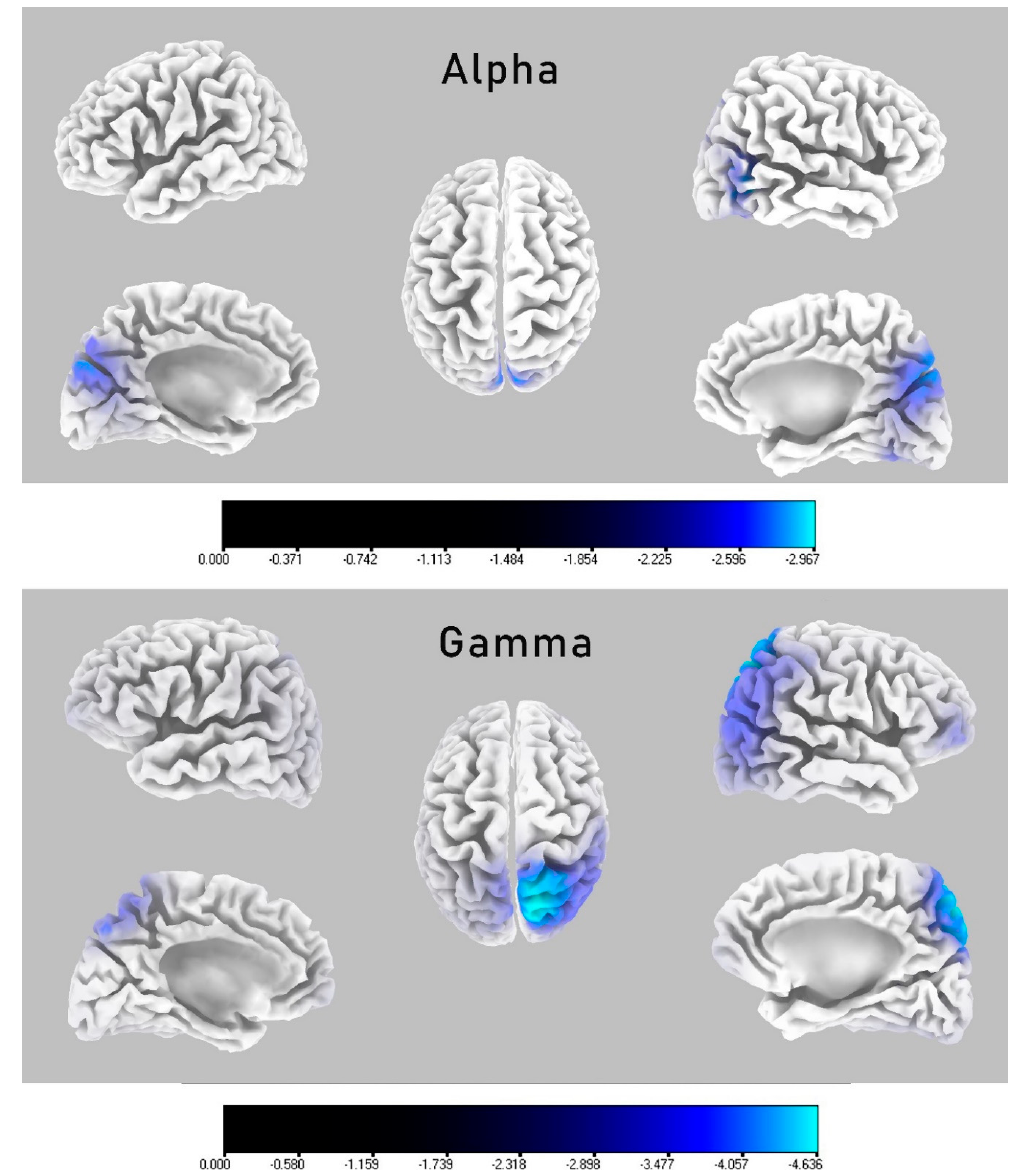
Figure 2. eLORETA spatial maps of voxels that were significantly di ff erentiating groups with respect to current source density distribution on a cortical surfaces. Di ff erences were labelled with di ff erent shades of blue due to decreased oscillations in the LHON group, with brighter spots of peak-to-max di ff erence voxels according to log F-ratio values. Each segment displays lateral and medial projections of the left and right hemisphere and the top view. Distribution of alpha frequency band (upper map) shows that LHON participants had significantly decreased current source density values in occipital and parietal lobes, with the voxels of peak di ff erence in the right middle occipital gyrus ( t max = − 3.86) and the secondary visual cortex ( t max = − 3.59). The lower map presents the distribution in the gamma frequency band, where LHON participants had significantly decreased current source density values in multiple brain areas, such as the parietal, occipital, and frontal lobes. The voxels o peak di ff erence was placed in the right superior parietal lobule ( t max = − 4.11), right precuneus ( t max = − 4.1), right angular gyrus ( t max = − 4.03), and right inferior parietal lobule ( t max = − 4.01). The low log(F-ratio) significance threshold for the gamma frequency band was log(F-ratio) = − 2.21 with p <